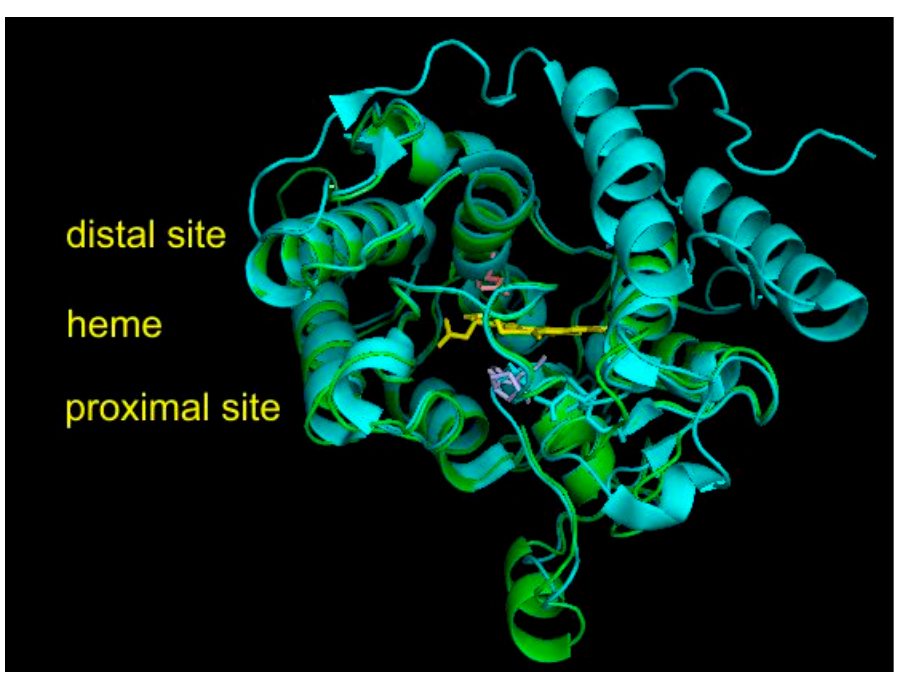
Figure 5. Structural overlay between AaeAPO (peroxygenase from Agrocybe aegerita data obtained from PDB file 2YOR [19]) with a homology model for RdelHTP (peroxygenase from Rhizopus delemar ) obtained with Phyre 2 [17]. Color scheme: AaeAPO—cyan, RdelHTP—green, prosthetic heme group—yellow, essential amino acid residues from RdelHTP (shown in the alignment of Figure 3) on the proximal site of heme—violet, amino acid residue on the distal site—pink. Rendered with PyMOL.